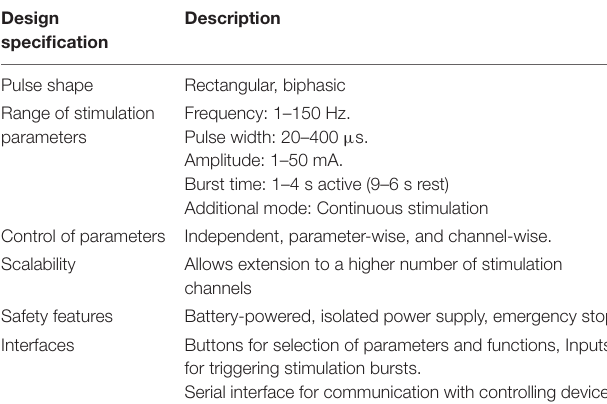
TABLE 1 | Required specifications and features of the FPGA-based architecture of the